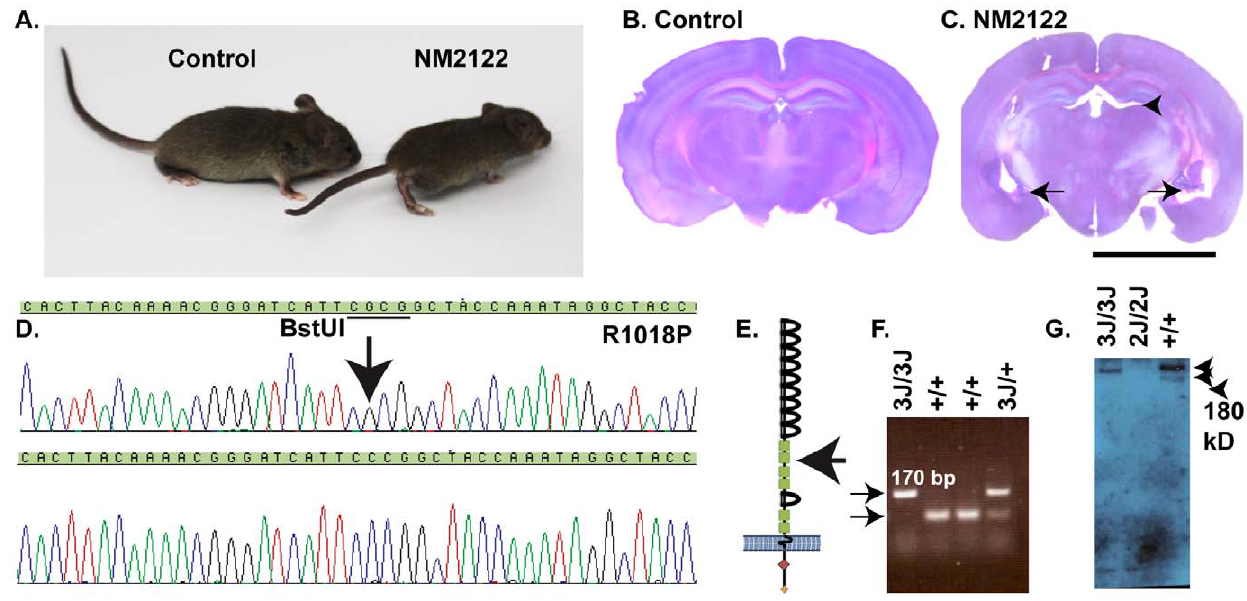
Figure 1. Amino Acid substitution R1018P is genetic basis of nm2122. A , A spontaneous mutation, nm2122, occurred at The Jackson Laboratory and exhibited overt phenotypes, including a large dome shaped head and muscle stiffness, similar to previously characterized Dscam mutants. B and C , nm2122 mutant mice develop enlarged central and lateral ventricles compared to controls (arrows). D , After complementation tests with another Dscam mutant, NM992 ( Dscam 2J ), failed, the Dscam open reading frame was sequenced and a single nucleotide substitution was found resulting in substitution of proline at 1018 in place of the wild type arginine. The nm2122 mutation will henceforth be referred to as Dscam 3J . E , The Dscam 3J mutation is located in the second fibronectin domain (arrow). F , The mutation destroys a recognition site for the enzyme BstUI, allowing wild type, heterozygous and homozygous mutants to be identified based on PCR of the mutation-containing region followed by subsequent restriction enzyme digest. The wild type allele is digested by BstUI resulting in two bands of close to equivalent size, while the mutant allele remains intact. G , Western blot analysis of wild type, Dscam 2J and Dscam 3J . A polyclonal antibody to the N-terminus of DSCAM recognizes a single band of approximately 220 kD and a slightly smaller band in retinal extracts prepared from wild type mice while a single band of 220 kD was detected in Dscam 3J extracts. No protein product is observed from retina (not shown) or brain extract prepared from Dscam 2J mice. The scale bar in (C) is equivalent to 1